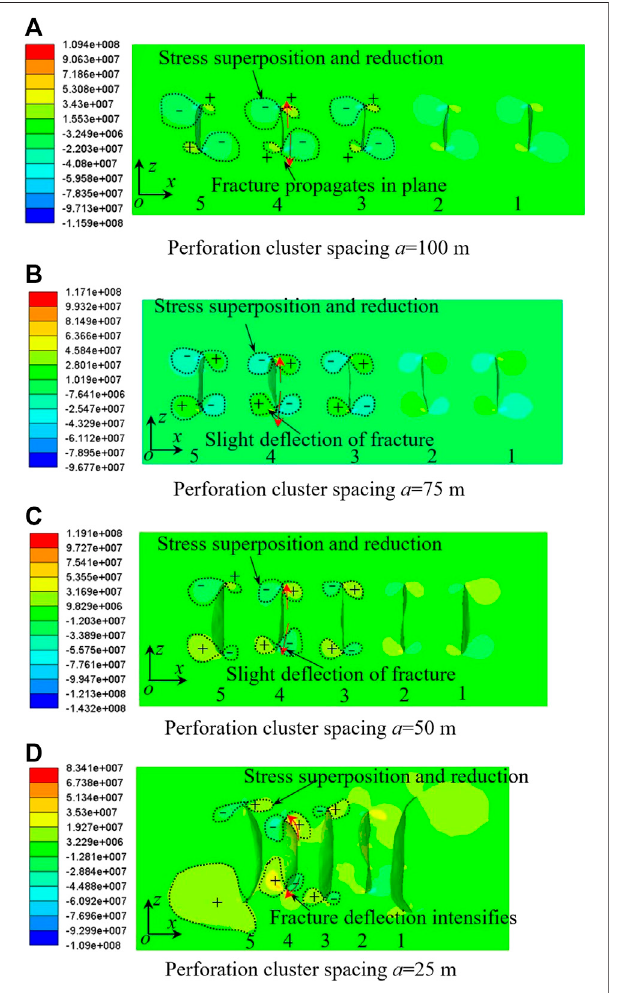
FIGURE 8 | Disturbance of shear stress σ zx (Pa) in alternate fracturing.